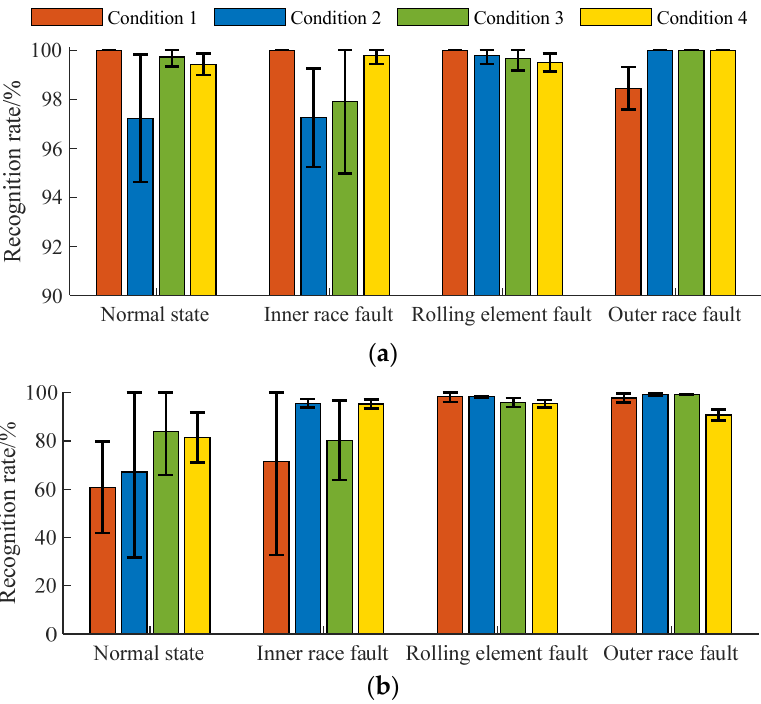
Figure 7. Average diagnosis accuracy of each in-wheel motor fault by multi-class SVDD based on other kernel functions: ( a ) polynomial kernel function; ( b ) Gaussian kernel